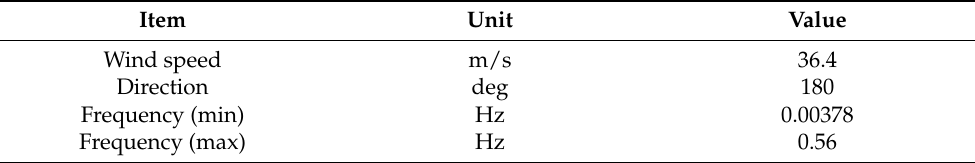
Table 6. Parameters of NPD spectrum in storm self-survival condition. Item